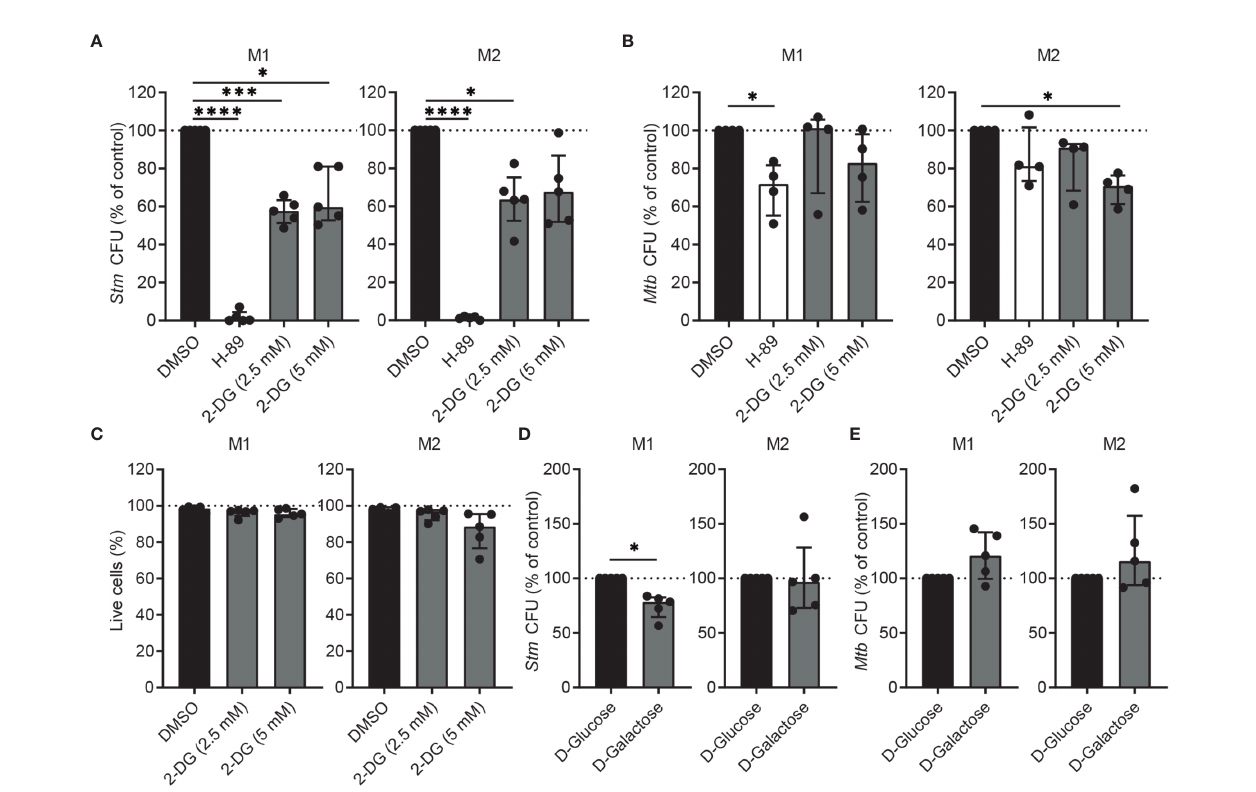
FIGURE 2 | Inhibition of glycolysis decreased intracellular Stm and tended to increase intracellular Mtb in human macrophages. (A, B) Stm and Mtb CFUs in M1 (left panels) or M2 (right panels) after treatment with H-89 (10 µM), 2-DG (2.5 or 5 mM) or vehicle control DMSO (0.1% v/v) overnight. Data represent the median ± interquartile range of minimally four donors. CFUs are expressed as percentage of DMSO. Differences were signi fi cant by RM one-way ANOVA with Dunnett ’ s multiple test correction against DMSO. (C) Percentage of live cells (i.e. Hoechst-positive, PI-negative cells) after overnight treatment with 2-DG (2.5 or 5 mM) or vehicle control DMSO (0.1% v/v) in M1 (left panel) or M2 (right panel). Data represent the median ± interquartile range of fi ve donors. Differences were tested by RM one-way ANOVA with Dunnett ’ s multiple test correction against DMSO. (D, E) Stm and Mtb CFUs in M1 (left panels) or M2 (right panels) cultured in medium containing D-glucose (11 mM) or D-galactose (11 mM) for 24 hours. Data represent the median ± interquartile range of fi ve donors. CFUs are expressed as percentage of DMSO. Signi fi cant differences were tested using a paired t-test. *p < 0.05, ***p < 0.001, ****p <